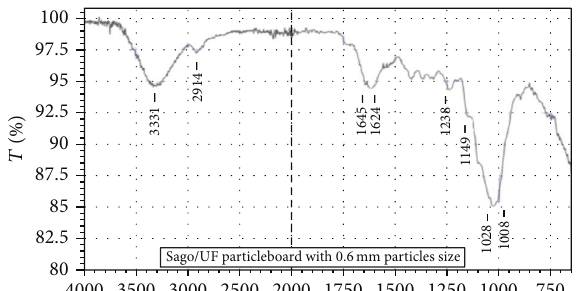
Figure 3: Sample A: Sago/UF Sample with particles size 0.6mm.